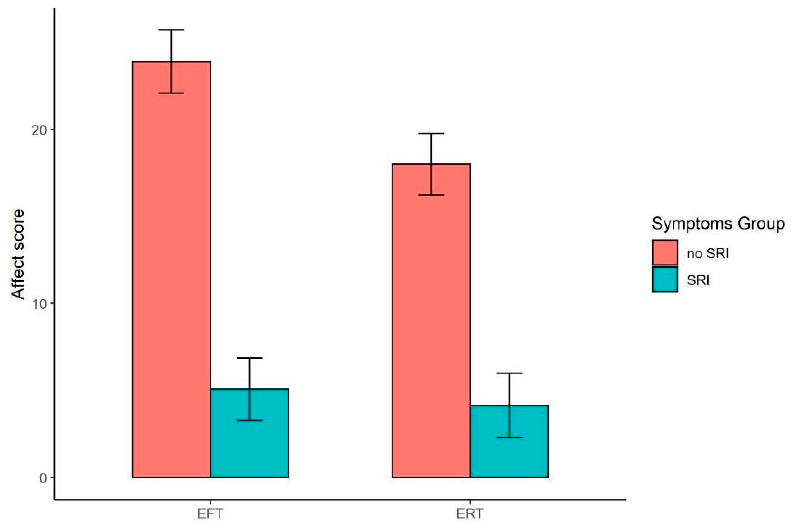
Figure 3. Mean covariate-adjusted affect scores (positive minus negative affect) in episodic future thinking (EFT) and smoking-related illness (SRI) groups. Higher values reflect greater positive vs. negative affect. Error bars represent standard error of the mean. A significant main effect of SRI was observed ( p < 0.001). No other main effects or interactions were significant (in all cases, p >